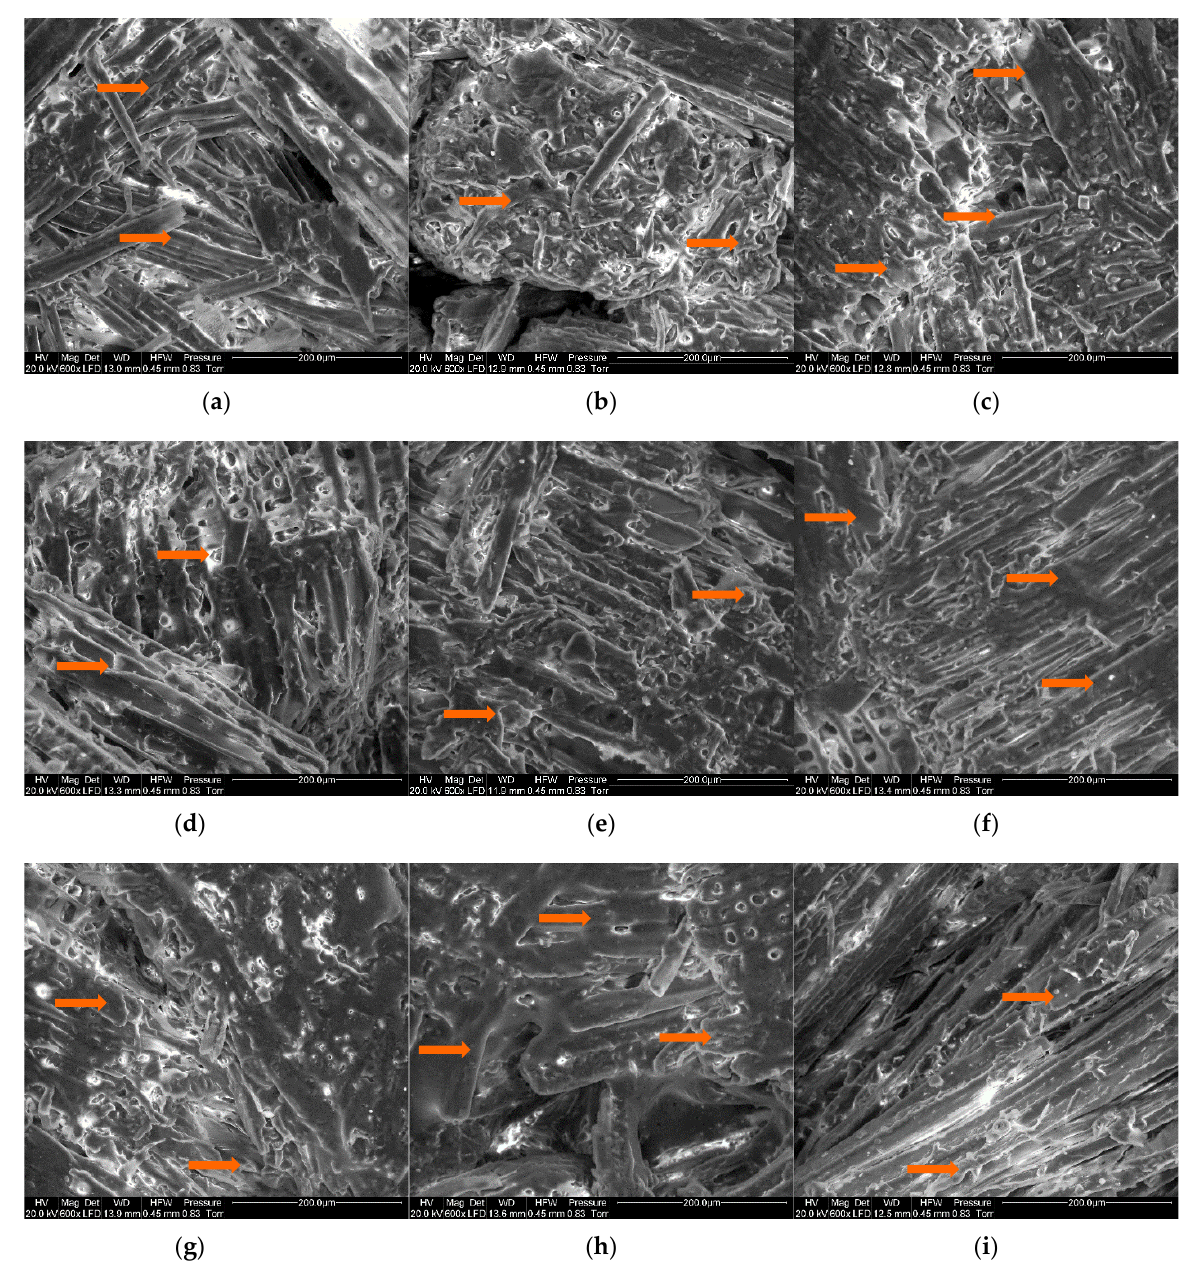
Figure 6. Scanning electron microscope images of lignocellulosic composites with ( a ) PLA12, ( b ) PLA15, ( c ) PLA20, ( d ) PCL12, ( e ) PCL15, ( f ) PCL20, ( g ) PS12, ( h ) PS20, ( i ) UF12; zones covered by binder indicated by arrows.